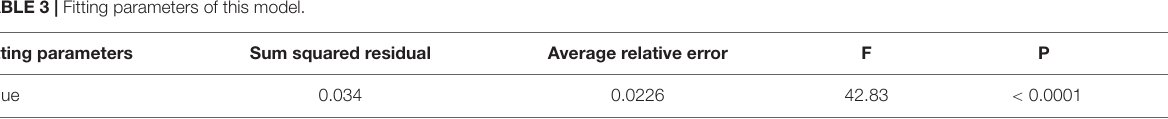
FIGURE 2 | (A) Relative error and (B) residual value of the dissolved oxygen concentration model. TABLE 3 | Fitting parameters of this